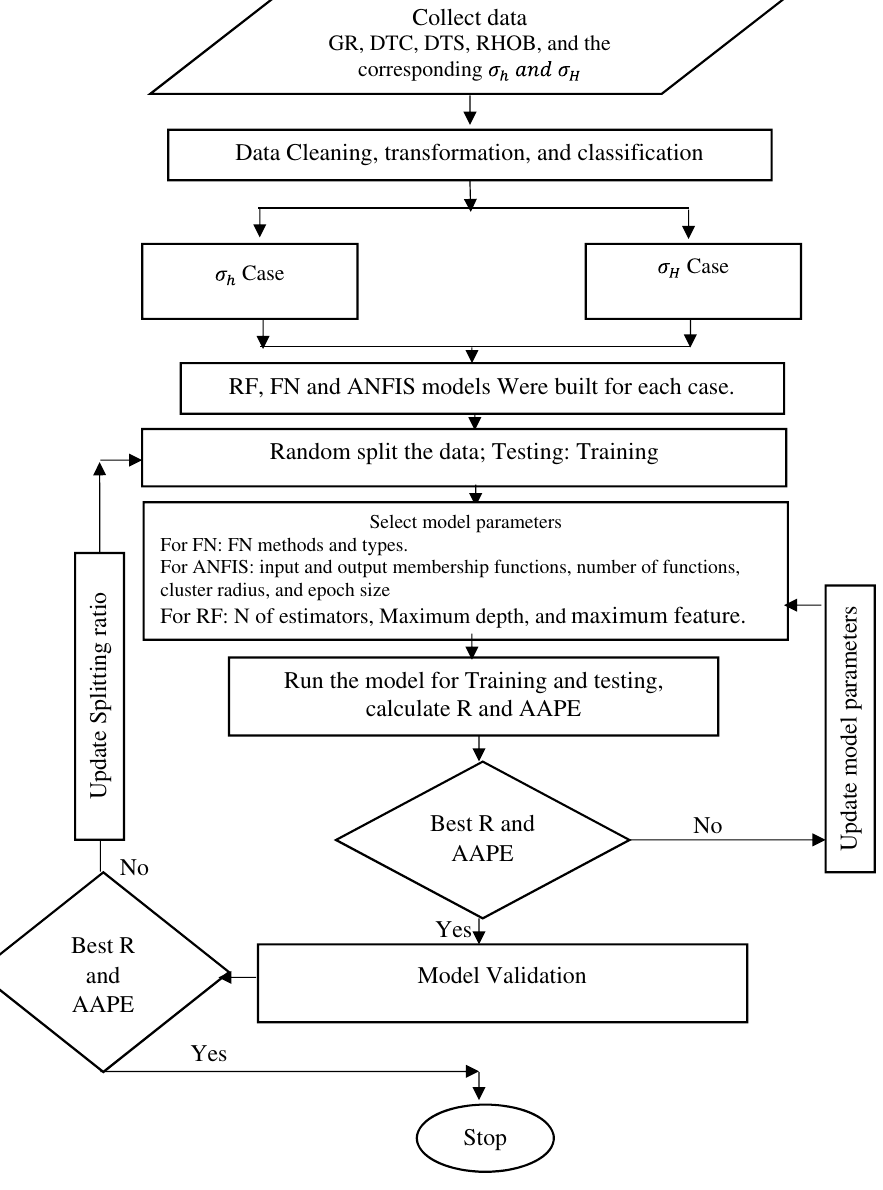
Figure 4. Flowchart for building the different RF, FN, and ANFIS